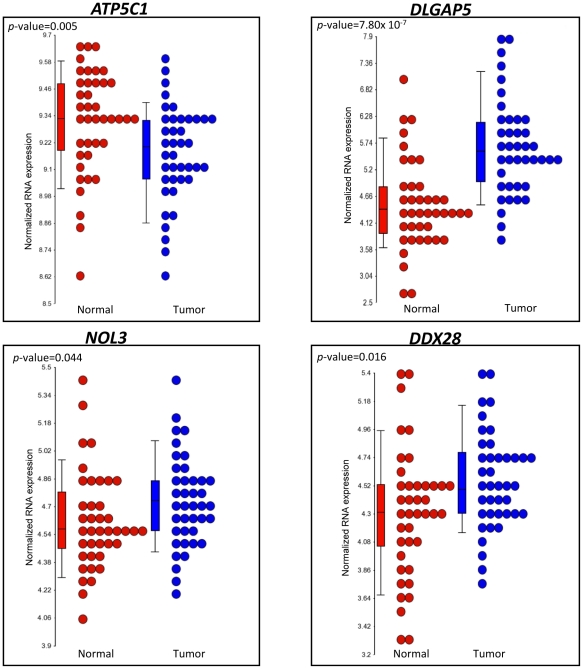
Tumor versus adjacent normal gene expression profiles of the cis-eQTL associated genes.Box plots of gene expression levels for ATP5C1, DLGAP5, NOL3, and DDX28 in paired adjacent normal colon tissue and colon tumor tissue (n = 40 pairs). The significance of differential expression is indicated by the p-value.